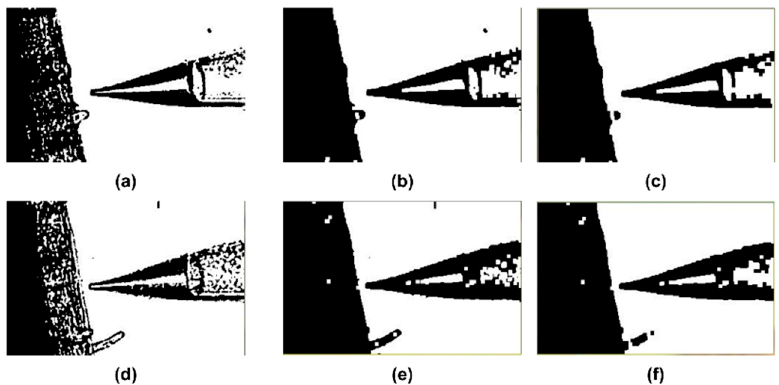
Figure 11. ( a ) and ( b ) are two binarized images, ( c ) and ( d ) are binary images after the open operation, and ( e ) and ( f ) are binary images after the close operation.